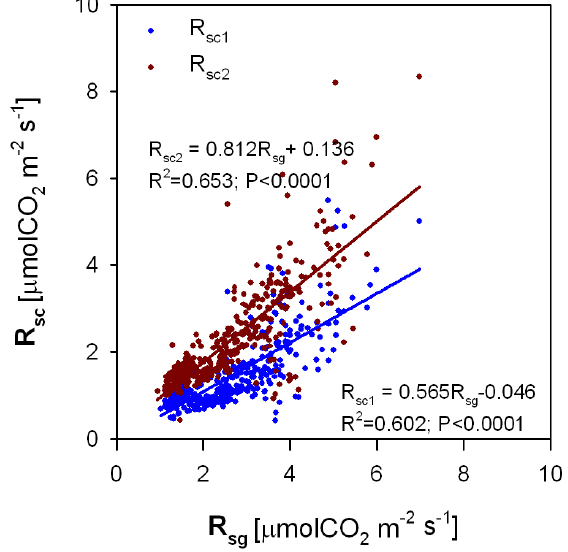
Fig. 11. Soil respiration as measured by the gradient method at the surface ( R sg ) vs. R sc (non-trenched, data sets of the two chambers are separated, R sc1 and R sc2 ) . Paired ( R sg and R sc ) data were used for fitting. R sg data during periods of inversion of the concentration gradients within the soil profile (after rains) were excluded from the regression.